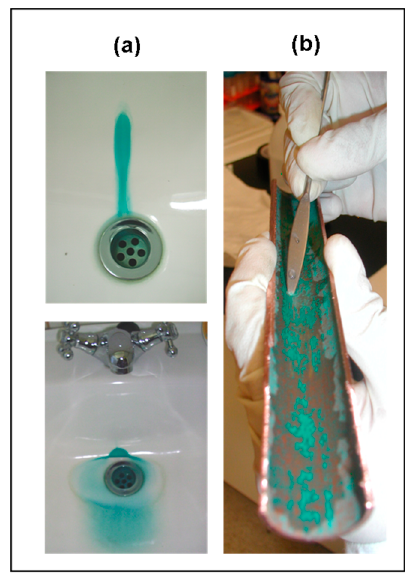
Figure 1. The effect of microbial biofilm formed on copper pipes household system: ( a ) bluish green stains in two sinks; and ( b ) two-year-old pipe affected by MIC.